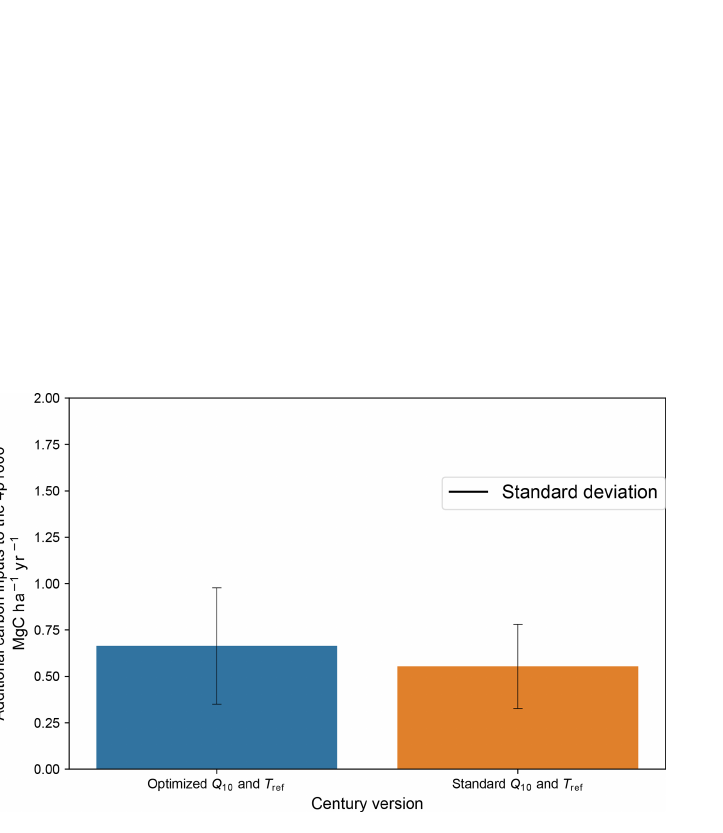
Figure C2. Effect of the optimization of the Q 10 and reference temperature ( T ref ) parameters on the additional carbon inputs to reach the 4p1000 predicted by Century (mean ± standard